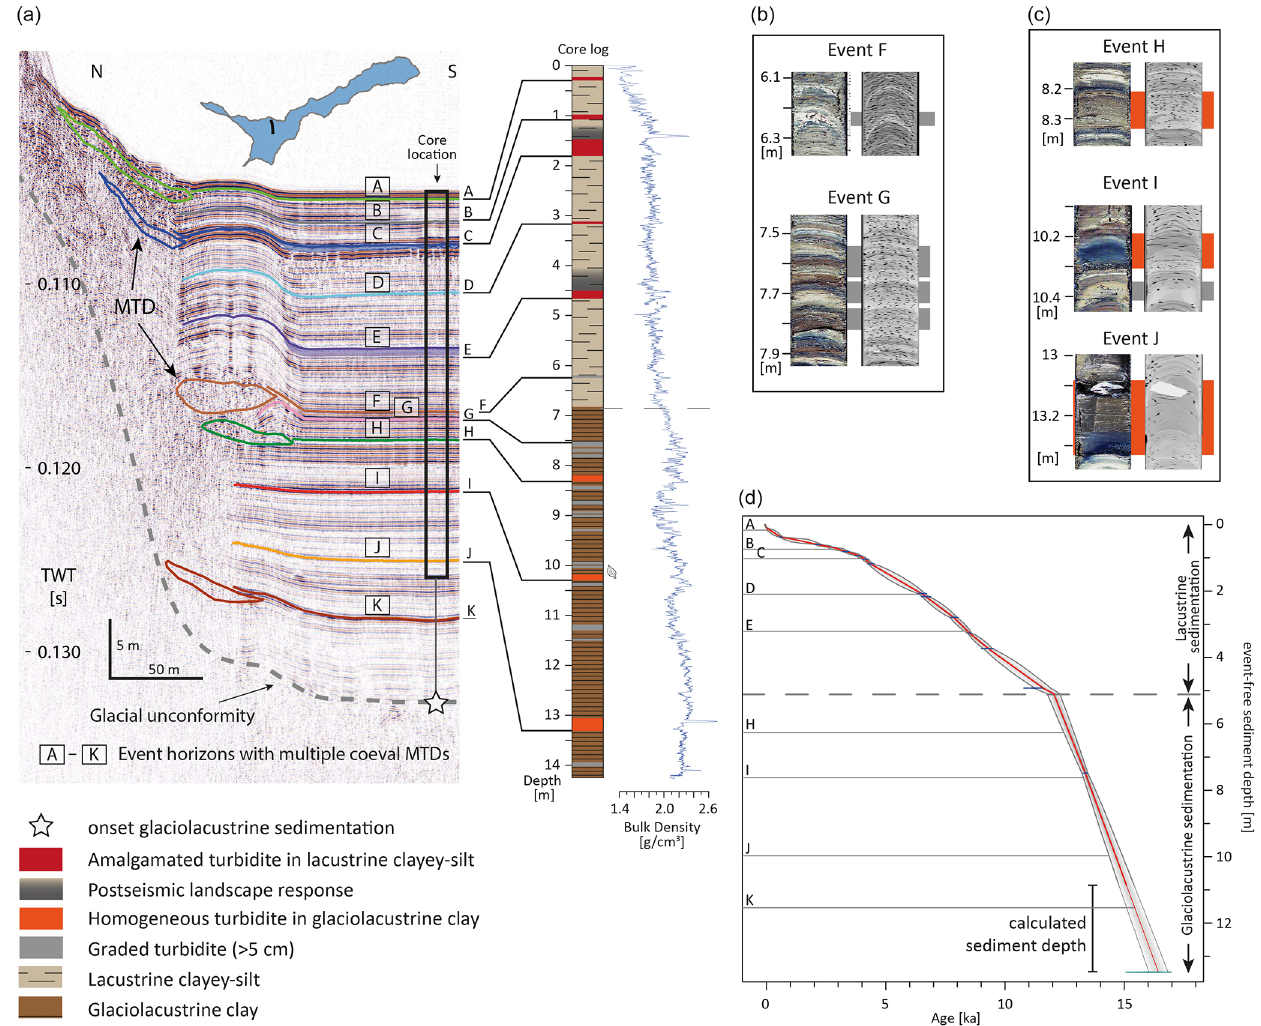
Figure 3. Extension of the paleoseismic record at Plansee. (a) Core-to-seismic correlation of the seismostratigraphic event horizons with multiple coeval MTDs (I–K) in seismic data to event deposits within the glaciolacustrine sediments. Correlation of event horizons A–E with amalgamated turbidites in the sediment core are derived from Oswald et al. (2021b). Core depth is extrapolated below the reach of the core to the onset of glaciolacustrine sedimentation. Inset figure shows the location of the seismic line on Plansee. (b) Single turbidites or a turbidite stack characterized by a normal grading and terrestrial macro-organic remains in histogram-equalized core images and CT data correlate to the seismic-stratigraphic event horizons F and G. These event horizons cannot be conclusively interpreted and either represent earthquakes or hydrological events. (c) Turbidites characterized by an overall homogeneous sediment body on top of a thin normally graded base in histogram-equalized core images and CT data are correlated to the seismic-stratigraphic event horizons H–J and are interpreted as earthquake-related deposits within the glaciolacustrine sediments. (d) Age–depth model of Plansee including calibrated 14 C ages from this study and Oswald et al. (2021b; Table S1) and an assumed lake initiation age ( ∼ 15–17ka) derived from the regional deglaciation age (Ivy- Ochs et al., 2008). Horizontal lines depict (projected) event horizons A–K. The dashed horizontal line represents the stratigraphic boundary between glaciolacustrine and lacustrine sedimentation. Sediment depths below the reach of the core (thin gray line) are calculated towards the glacial unconformity from TWT in seismic data assuming an acoustic velocity of 1610ms − 1 .